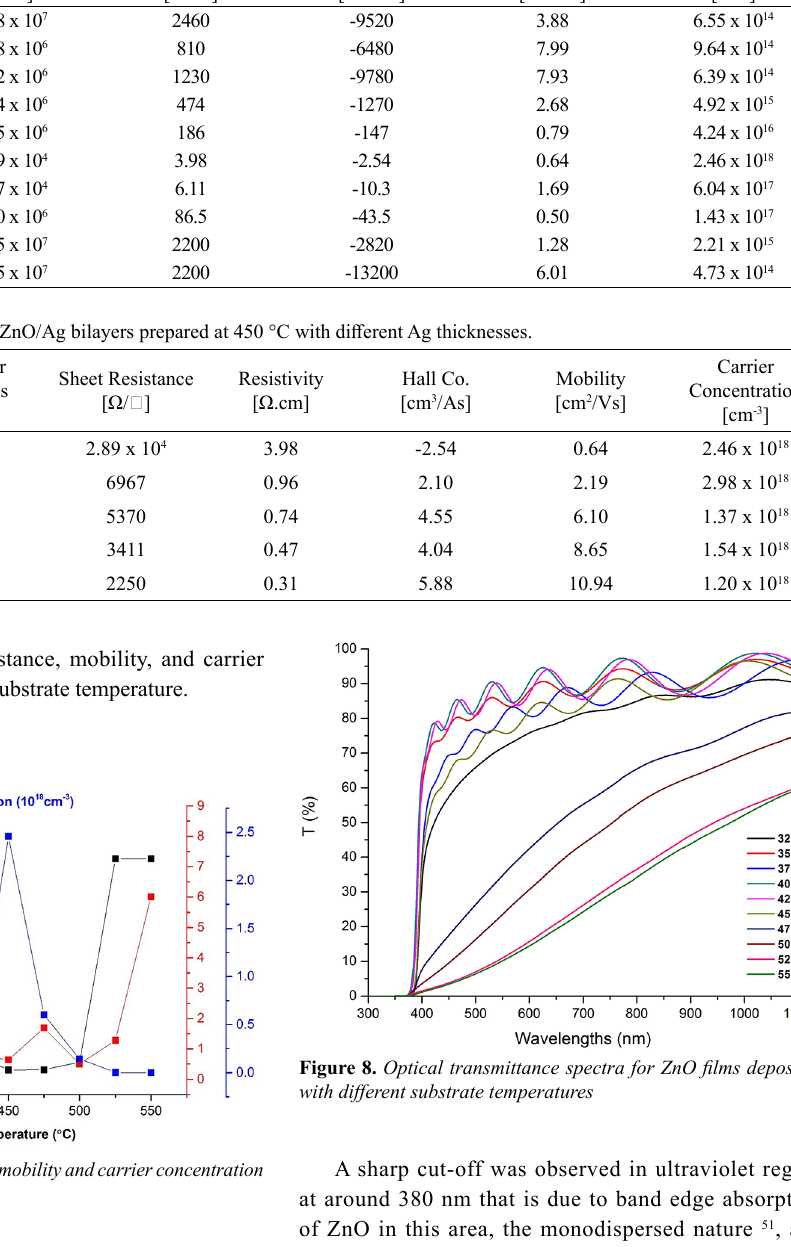
Table 4. Electrical properties of ZnO thin films prepared at different substrate temperatures. Temp. [°C]